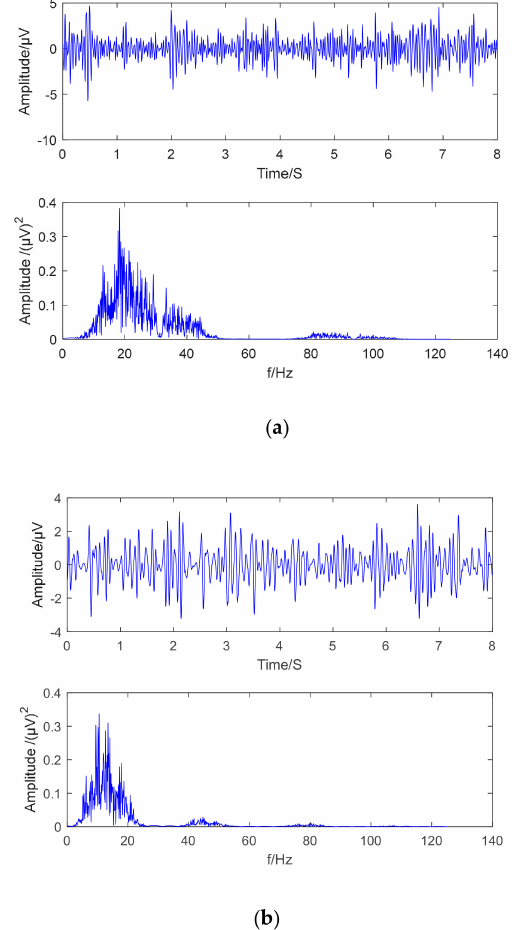
Figure 6. Wavelet decomposition sub-band signal (upper waveform, lower spectrum): ( a ) Wavelet decomposition sub-band signal D3; ( b ) Wavelet decomposition sub-band signal